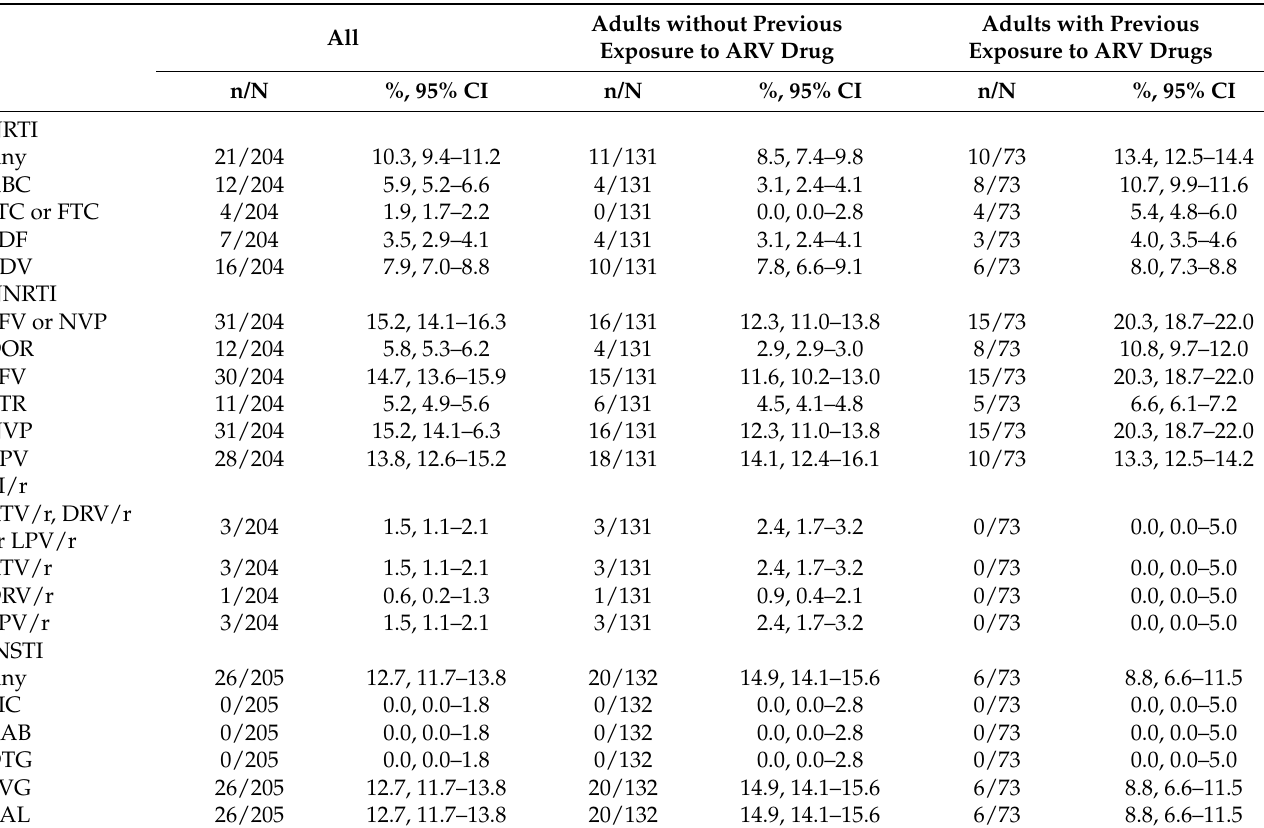
Table 3. Prevalence of HIV drug resistance among adults initiating and reinitiating ART with and without previous exposure to ARV drugs in Uruguay, 2018–2019. Adults without All